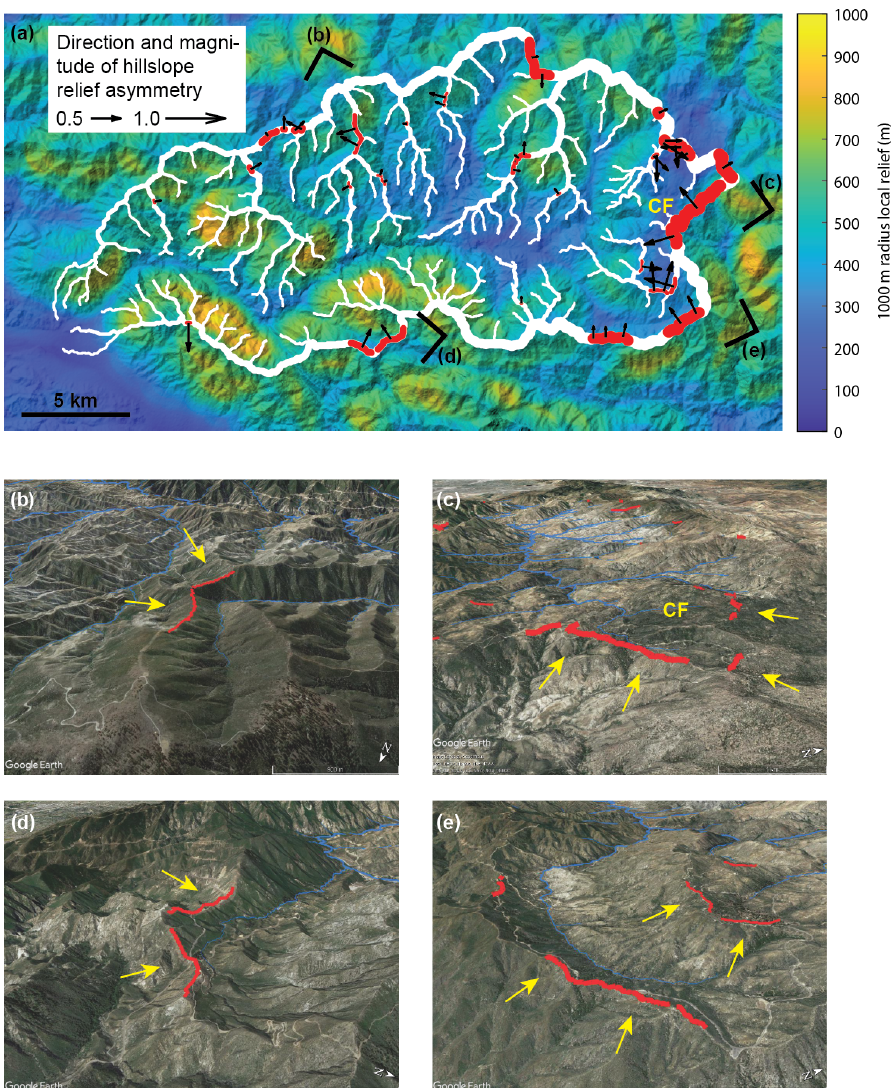
Figure 12. Anomalous divides in the Big Tujunga catchment. (a) A 1000m radius local relief map draped over the hillshade image. White lines show the divide network, and red lines depict asymmetric (DAI > 0 . 4) divide edges with minimum hillslope relief < 200m and min- imum flow distance < 1000m. Black arrows indicate the direction and magnitude of the DAI, with the arrow pointing in the direction of lower relief, i.e., the inferred direction of divide migration. (b–e) Oblique Google Earth© views of asymmetric divides shown in panel (a) . CF: Chilao